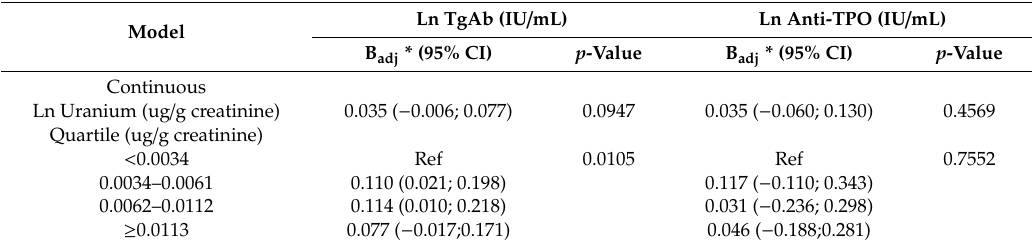
Table 2. Adjusted * beta coe ffi cients (95% CI) for the association between urinary uranium and thyroid